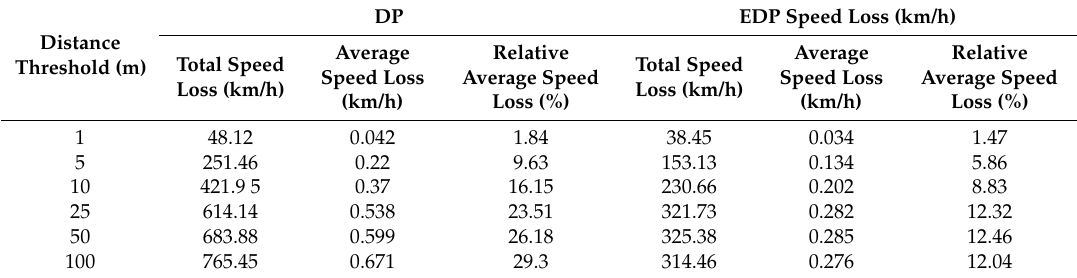
Table 2. Speed loss of DP and EDP simplification on Dataset 1 with different distance thresholds.